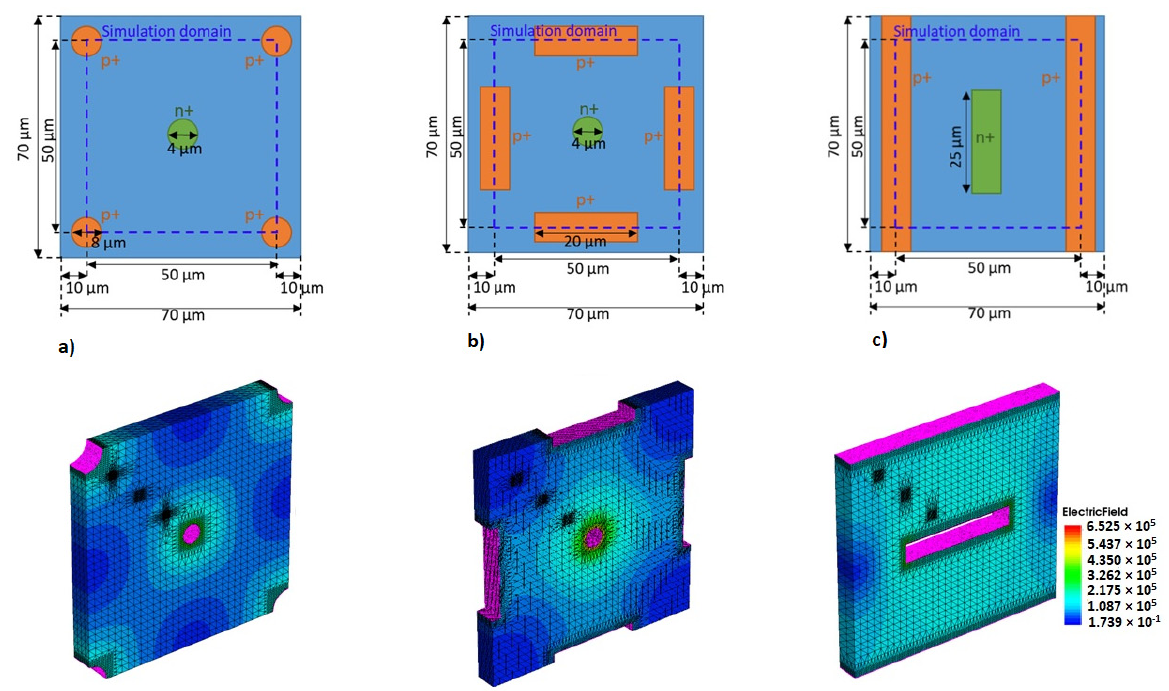
Figure 12. Simulated cells for the different 3D electrode configurations, from left to right: ( a ) full columns, ( b ) hybrid trenches/columns, ( c ) full trenches. The units for the electric field are V/cm.